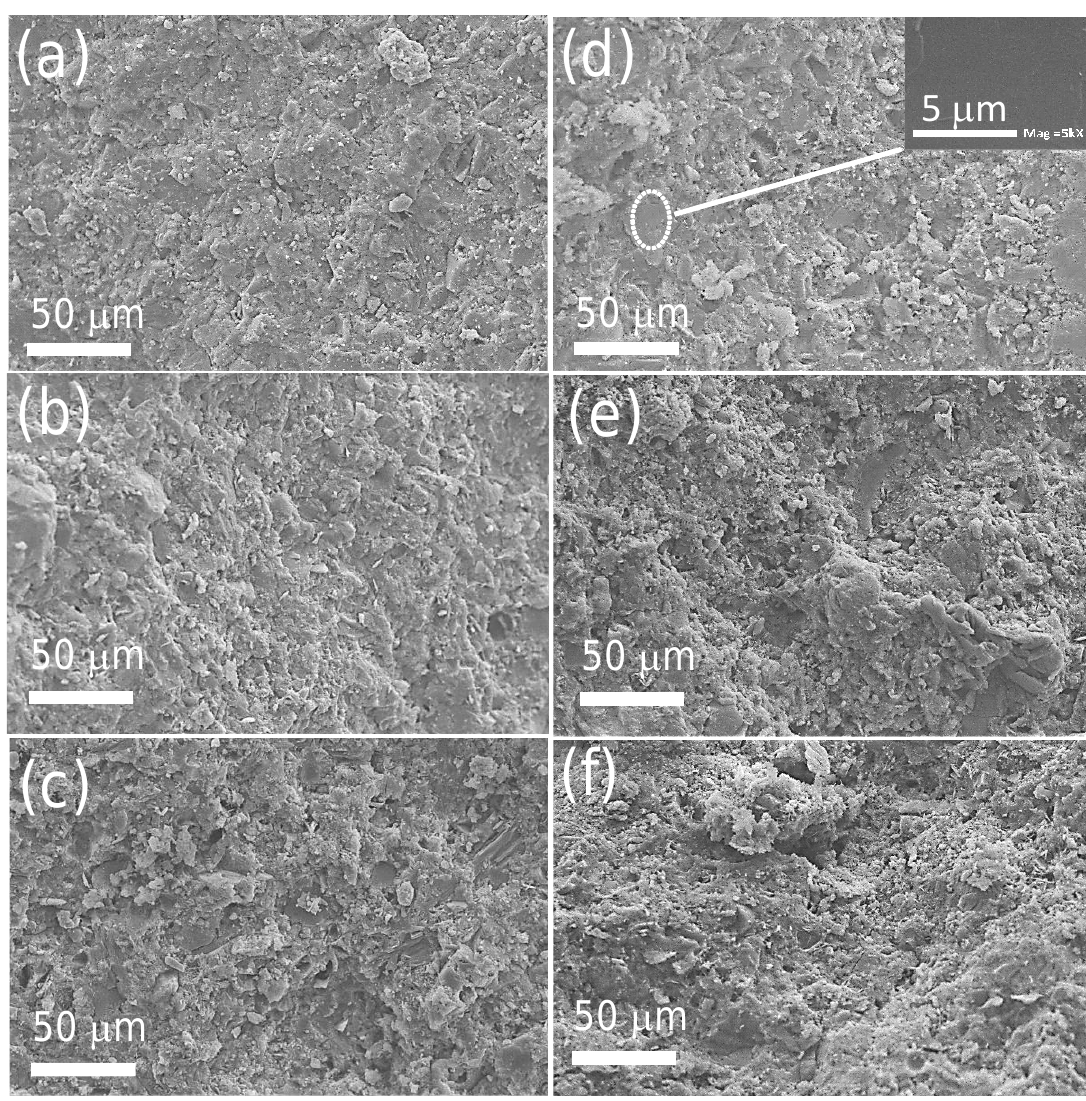
Figure 4. SEM images of the cross-sections of the ( a ) CTAB/PC1, ( b ) CTAB/PC2, ( c ) CTAB/PC3, ( d ) (CTAB + NL)/PC1, ( e ) (CTAB + NL)/PC2, and ( f ) (CTAB + NL)/PC3 composites. The inset of ( d ) shows the flat, smooth surface of the NL.